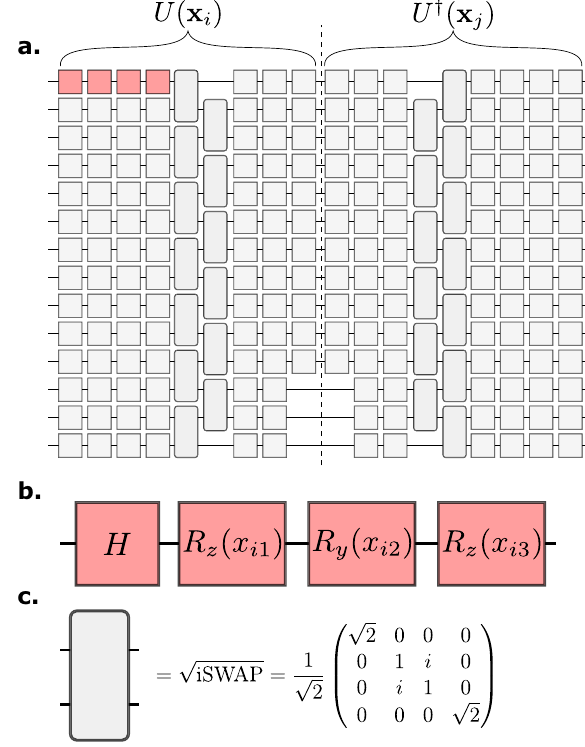
Fig. 2 Circuit diagram for kernel function. a 14-qubit example of the circuit used for experiments in this work. The dashed line indicates the boundary between U ( x i ) and U † ( x j ), which are run sequentially to sample ∣ 〈 ϕ ( x j ) ∣ ϕ ( x i ) 〉 ∣ 2 . Non-virtual gates occurring at the boundary are contracted for hardware runs. b The basic encoding block consists of a Hadamard followed by three single- qubit rotations, each parameterized by a different element of the input data x (normalization and encoding constants omitted here). c ffiffiffiffiffiffiffiffiffiffiffiffiffiffiffi p iSWAP We used the entangling gate, a hardware-native two-qubit gate on the Sycamore